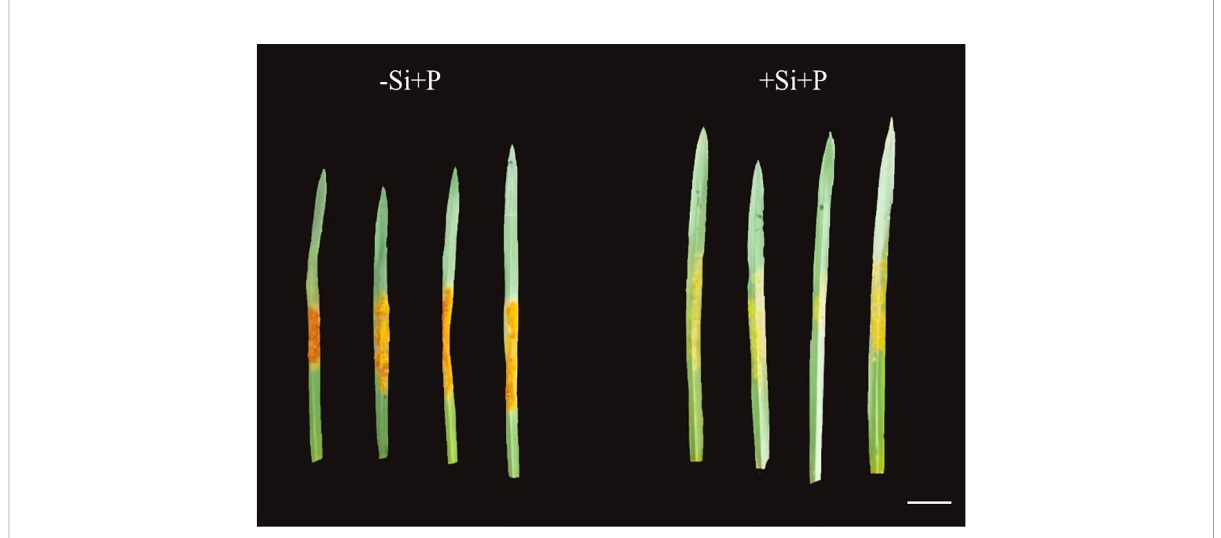
FIGURE 1 Effects of Si application and Pga inoculation on phenotype of oat, scale bar=1 cm. -Si+P, no Si application and Pga inoculation; +Si+P, 1.5 mmol·L – 1 Si application and Pga